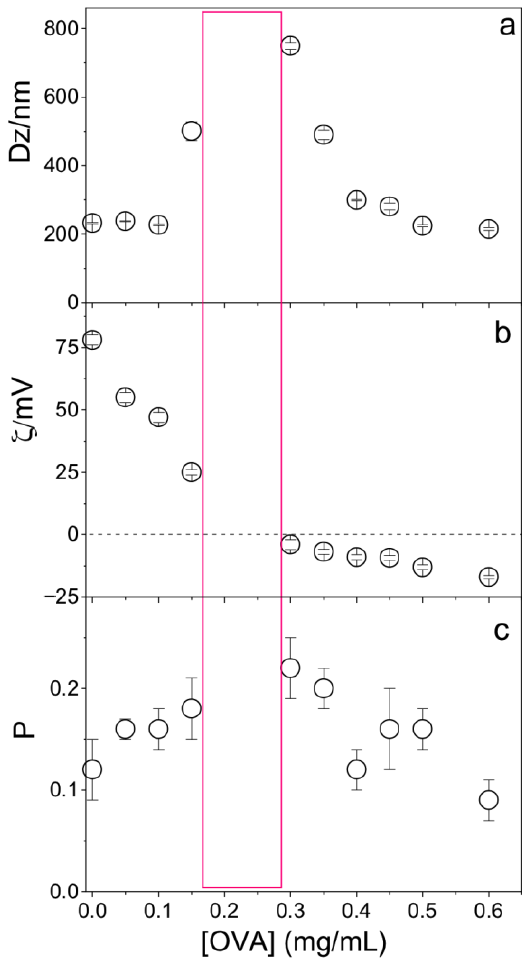
Figure 6. Effect of ovalbumin (OVA) concentration on ( a ) the mean hydrodynamic diameter (Dz), ( b ) zeta-potential ( ζ ), and ( c ) polydispersity (P) of PMMA/DODAB/PDDA NPs. The red rectangle indicates the zone where the dispersion was not colloidally stable and DLS measurements were not reliable.